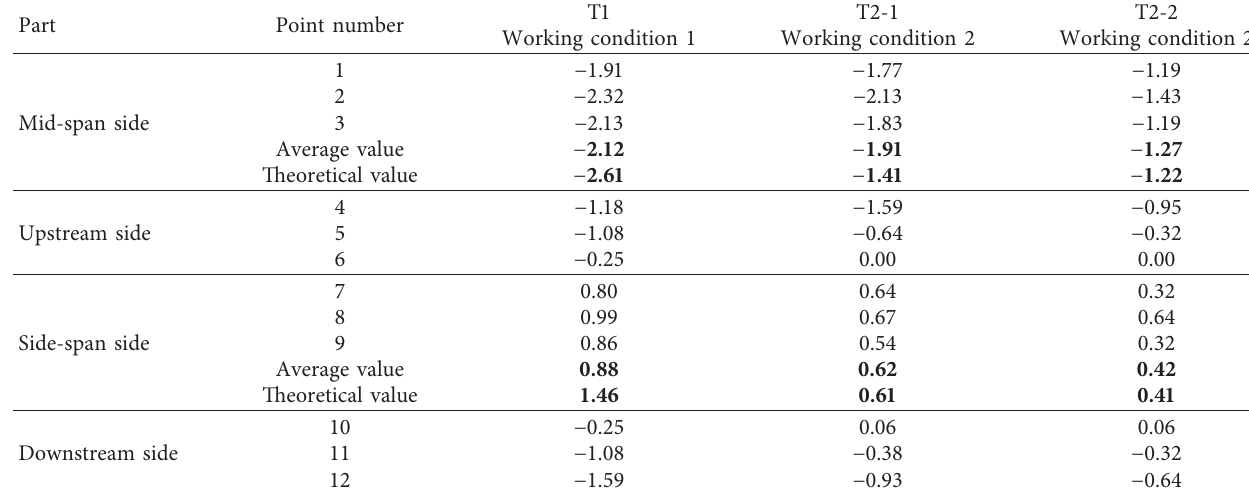
Table 1: Test section stress of no. 4 tower column (unit: MPa).